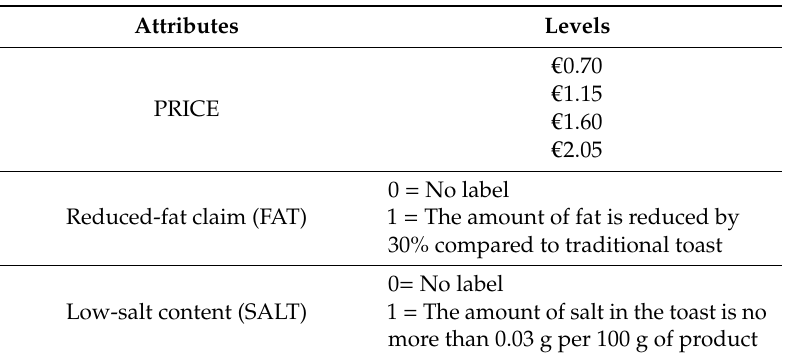
Table 1. Attributes and levels used in the choice experiment (CE)